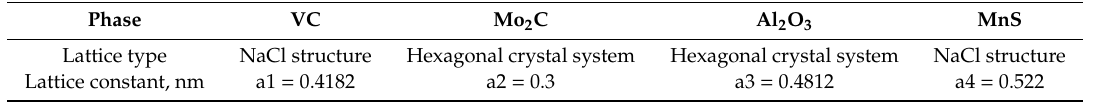
Table 2. Lattice constants of the studied